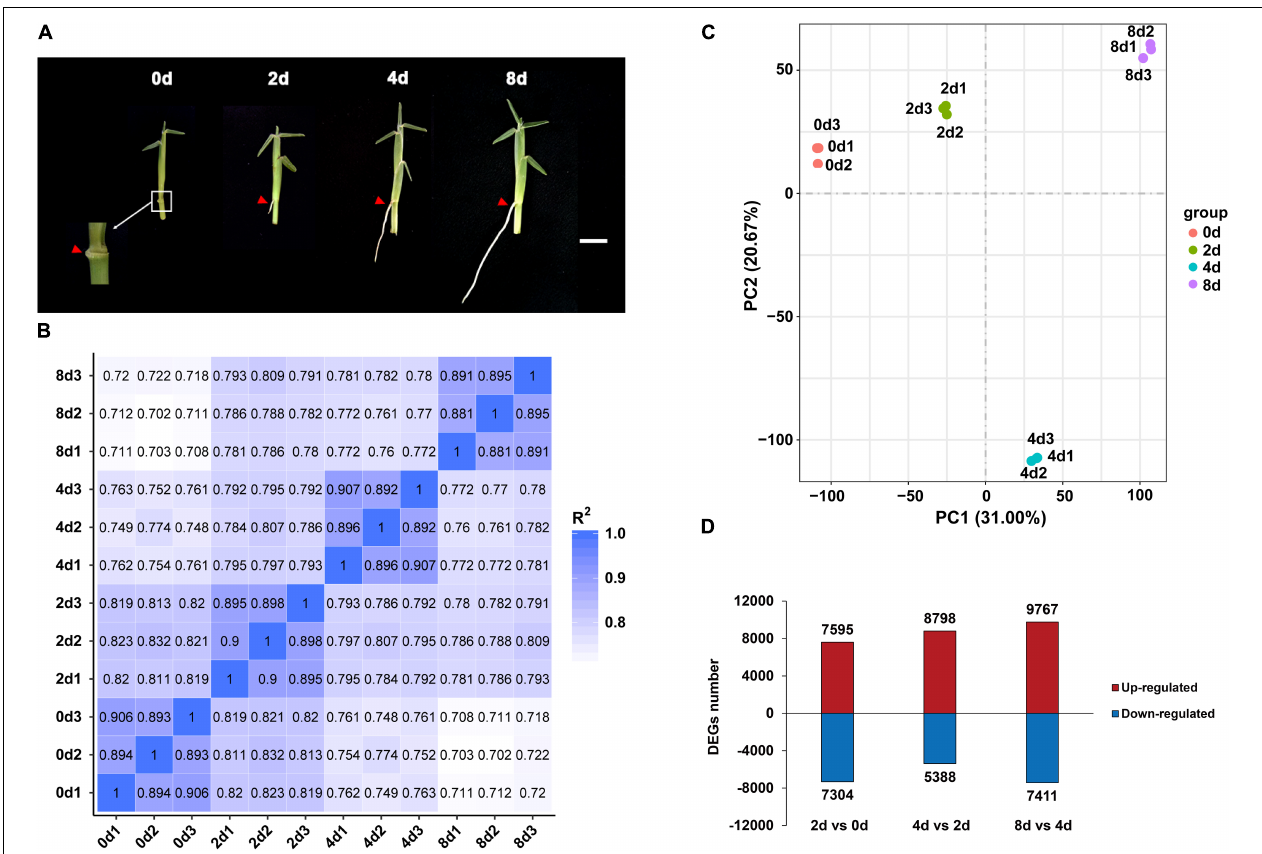
FIGURE 2 | Expression profiles of centipedegrass E039 nodal roots. (A) The first nodal roots of E039 were exhibited in 0 day (the root length about 0.1 cm), 2 days (the root length about 0.5 cm), 4 days (the root length about 2.0 cm), and 8 days (the root length about 4.0 cm) after water culture. The roots are indicated by red triangles. Scale bar represents 1 cm. (B) Pearson’s correlation between 12 samples. (C) PCA of 12 transcriptome samples. (D) The number of upregulated and downregulated DEGs in 2 days vs. 0 day, 4 days vs. 2 days, and 8 days vs. 4